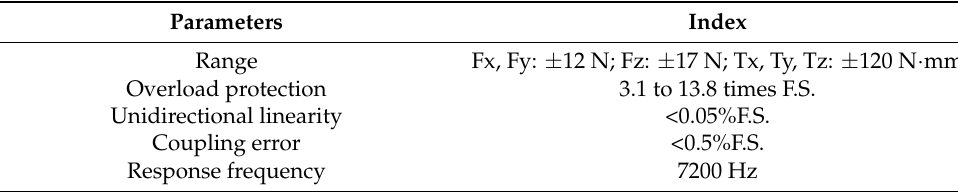
Table 1. Parameters of